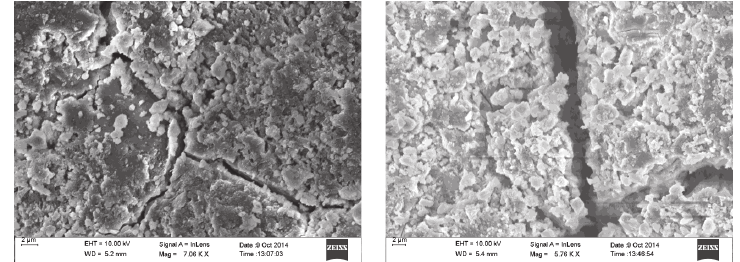
Figure 2: Scanning electron microscope image of slag in 2 𝜇 m magnification.